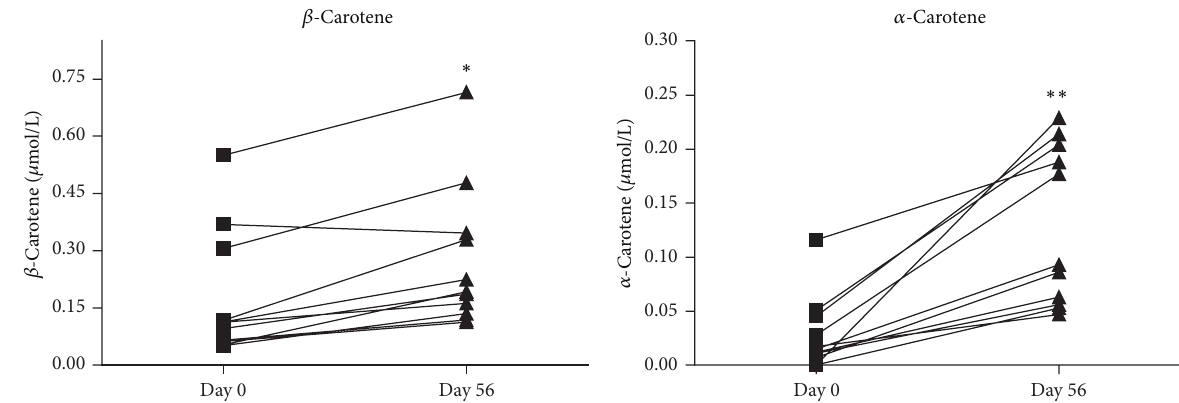
Figure 1: Change of plasma concentration of 𝛽 -carotene and 𝛼 -carotene in the blood of CF patients after eight weeks of supplementation with red palm oil. Values are given in 𝜇 mol/L. Concentrations of both 𝛽 -carotene and 𝛼 -carotene were significantly increased (day 56) compared with baseline (day 0) ( ∗ 𝑃 < 0.002 , ∗∗ 𝑃 < 0.001